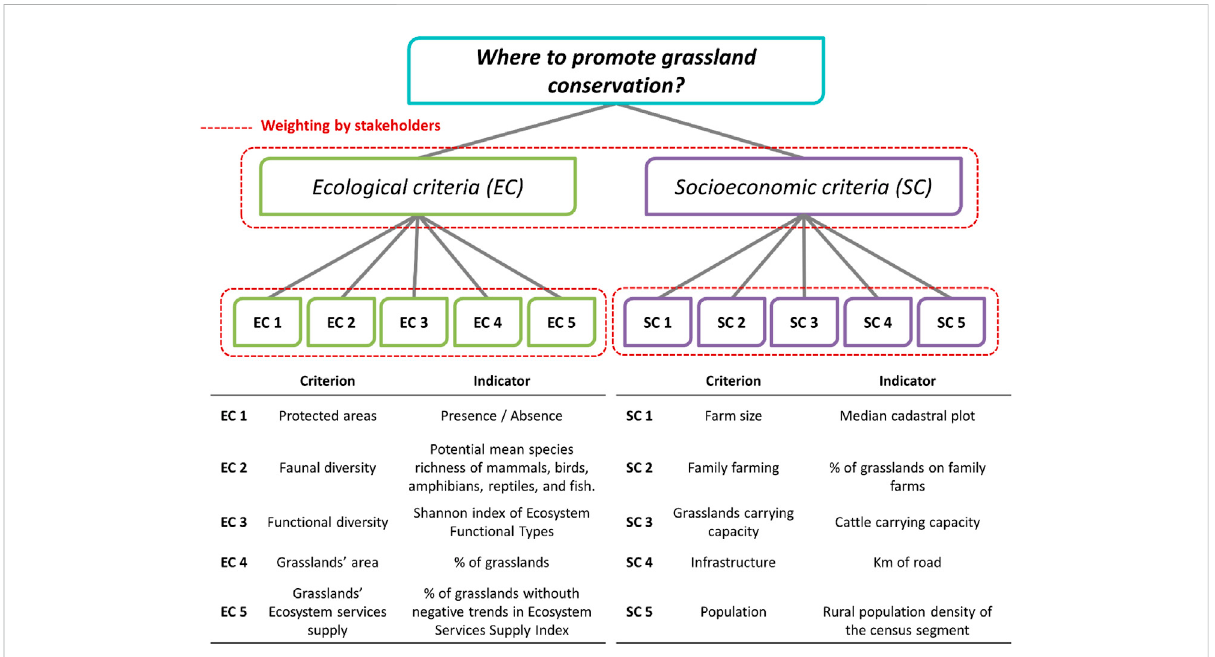
FIGURE 2 Hierarchical structure used to determine the Grasslands ’ Conservation Value (GCV). The question to be answered is which cells (5 x 5 km) have higher conservation value. The criteria to answer that question were grouped into two categories: ecological (EC 1 to EC 5) and socioeconomic (SC1 to SC5), which were characterized by a spatially explicit diagnosis of their indicators. Each dotted red box encloses the elements that the stakeholders compared in the three weightings carried out. Each comparison gives rise to a weighting vector representing the relative importance of each element with respect to the others, whose sum is equal to